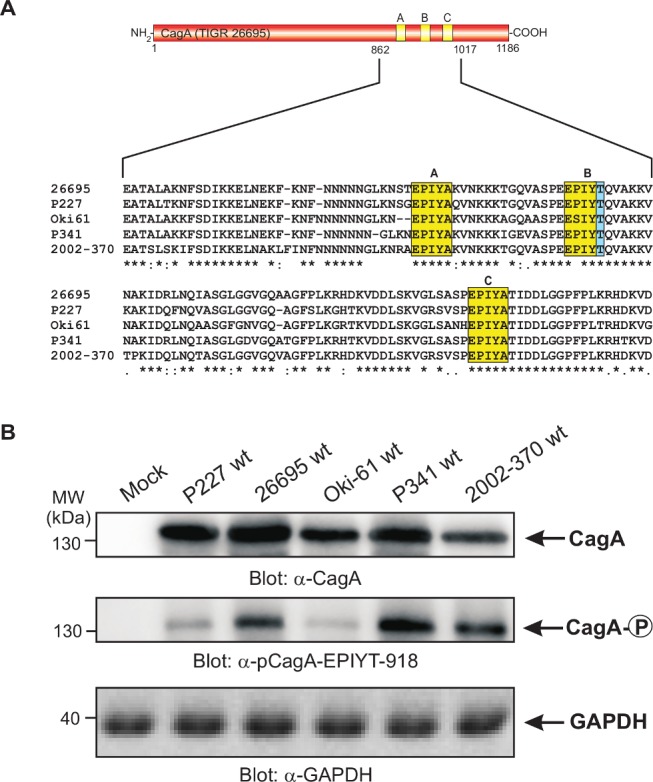
Sequence comparison of the three TPM sites in CagA proteins from different clinical H. pylori strains and specific detection of phosphorylated EPIYT-motif during co-culture.
Panel A: CagA proteins of H. pylori vary in their carboxy-terminal TPM sites. These EPIYA-repeats serve as tyrosine phosphorylation sites of CagA and can be targeted by c-Abl and c-Src kinases. Three EPIYA- or EPIYT-segments at position A, B and C are shaded with yellow. One striking feature of B-TPM is the presence of a threonine residue in the +1 position (shaded with blue) relative to the phosphorylated tyrosine residue, which is highly conserved in most but not all H. pylori strains and may affect the capabilities of binding the p85 subunit of PI3-kinase, as discussed in the text. The CagA protein sequences were obtained from databases and sequence alignment was done using the ClustalW2 program (http://www.ebi.ac.uk/Tools/msa/clustalw2/). Panel B: To investigate whether the EPIYT-motif can be phosphorylated during co-culture, AGS cells were co-incubated with the indicated CagA-expressing H. pylori strains for 6 h. Phosphorylation of CagA was examined using the phospho-specific α-pCagA-EPIYT-918 antibody. Loading of equal amounts of protein in each sample was confirmed by probing with monoclonal α-CagA and α-GAPDH antibodies.